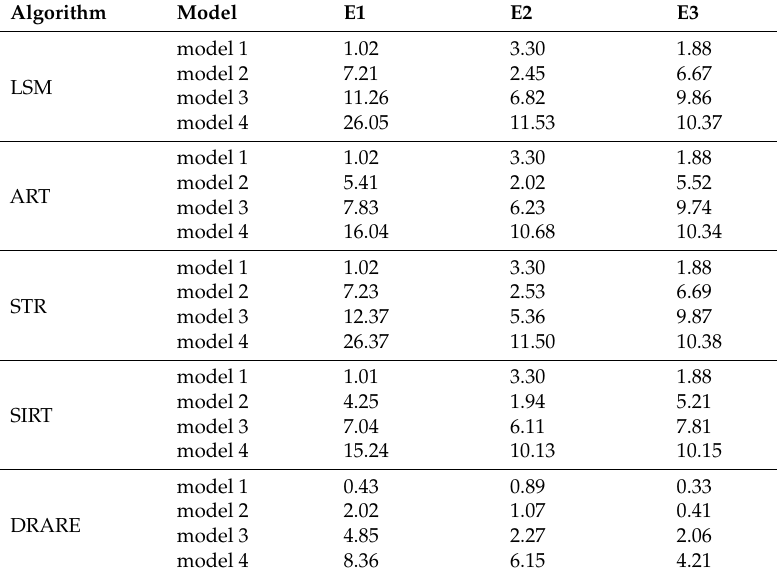
Table 2. Errors of reconstruction results %.